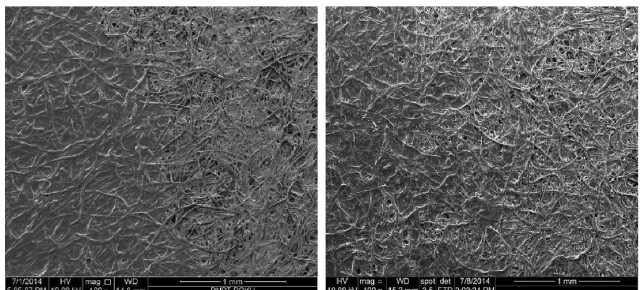
Figure 8. Left: paper treated with BNC; a clear borderline between the treated ( left ) and the untreated ( right ) areas is visible. Right: paper treated with CNF; the borderline between the treated ( left ) and untreated ( right ) areas is not as clear as with BNC. Reproduced under terms of the CC-BY license [89]. Copyright © 2017, The Authors, published by Springer Nature. Otherwise, in both cases, the modification performed with the addition of gelatin in- creased the stability of nanocellulose film but left the treated surface very sensitive to the mois- ture and stickier compared to the nanocellulose suspensions without gelatin. However, with these treatments, the damaged areas of paper were consolidated, as visible in Figure 9, and the results of the application of BNC and CNF suspensions were comparable with the adhe- sive consolidation; they did not alter the visual appearance of ancient papers, even in the long term, and permitted an innovative approach for paper stabilization.